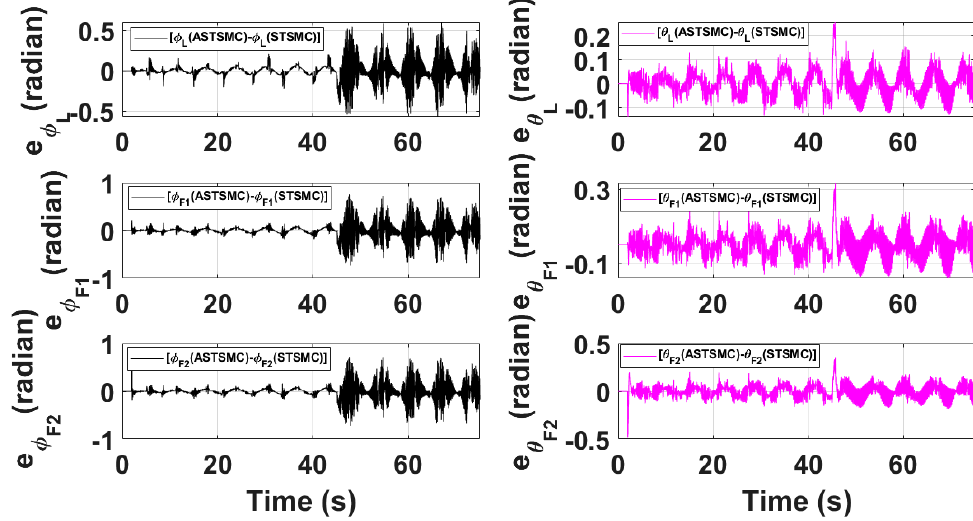
Figure 17. Difference between desired θ , φ with ASTSMC and STSMC